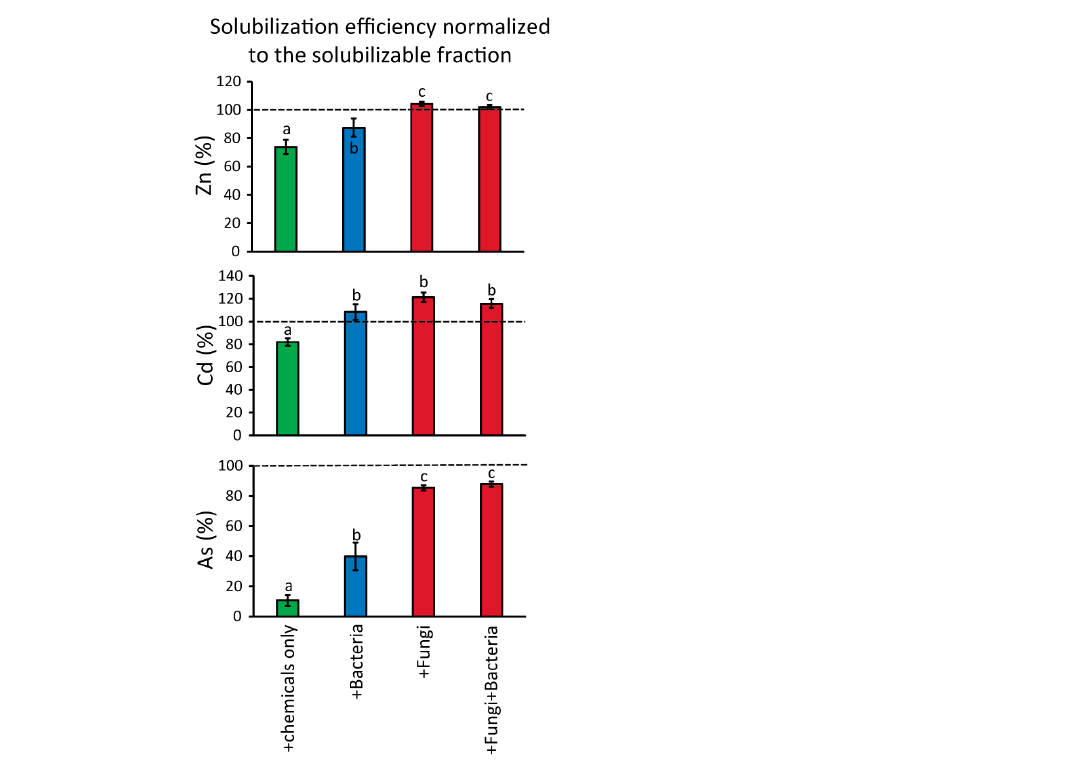
Figure 3. Solubilization efficiency normalized to the extractable fraction of Zn, Cd, and As. Reported are the solubilization efficiency values obtained by the four main different conditions used in this study: chemicals only, bacteria, fungi, and the mix of bacteria and fungi. Different letters in the bar charts highlight significant differences among values.